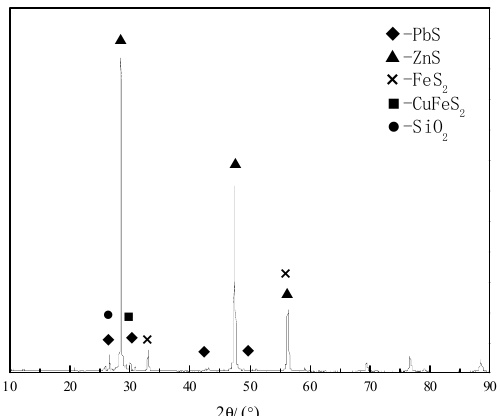
Figure 1. XRD pattern of the ZnS concentrate with identified mineral phases. Minerals 2019 , 9 , x FOR PEER REVIEW